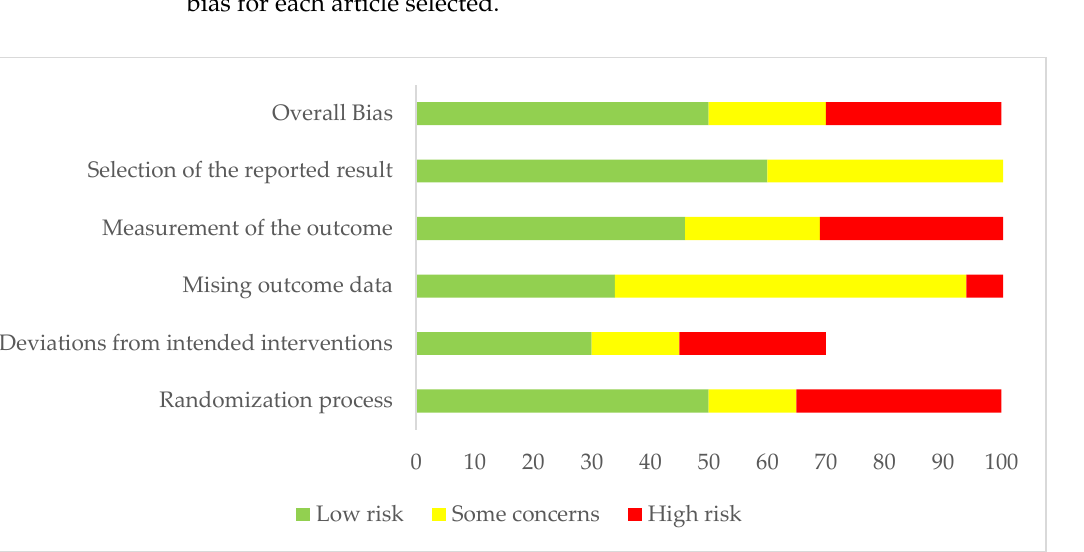
Table 3. Inclusion and exclusion criteria list.